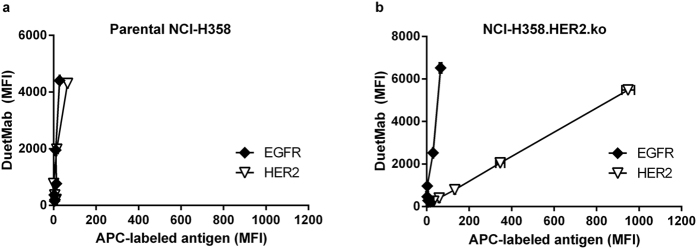
Concurrent binding of DuetMab to EGFR and HER2 receptors on the surface of the same cell.(a) Concurrent binding analysis of anti-EGFR/HER2 DuetMab to parental NCI-H358 cells. (b) Concurrent binding analysis of anti-EGFR/HER2 DuetMab to NCI-H358.HER2.ko cells. To determine concurrent binding of EGFR and HER2 receptors by cell-bound DuetMab, each cell population was examined individually using fluorescent dye labeled EGFR and HER2 antigens. (Y-axis), Detection of cell-bound DuetMab. (X-axis), Detection of free antigen binding arms on cell-bound DuetMab. Data points refer to serial dilutions of the DuetMab starting at a sub-saturating concentration of 1.2 nM. Each point represents the mean values of duplicate wells and the ± standard error of the mean (SEM) is represented by error bars.